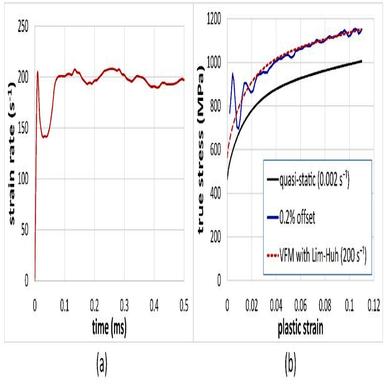
Validation of the identified stress-strain curve of DP780 with the VFM (a) AOI-averaged strain rate (b) comparison of the stress-strain curves between by the VFM and by 0.2% offset method.